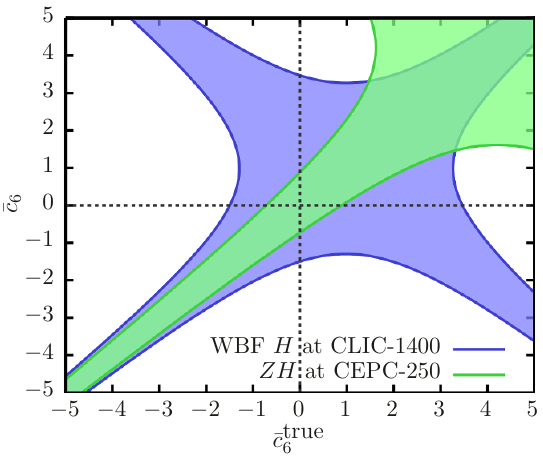
in single Higgs production in the Scenario 1 6